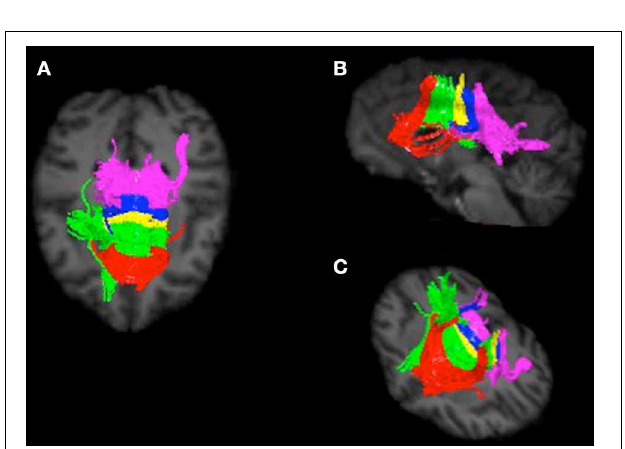
FIGURE 4 | Callosal fiber projections from a single male chimpanzee, displayed from (A) dorsal, (B) sagittal, and (C) oblique views. Color distinguishes fibers projecting into cortical regions and are as follows: prefrontal (red), premotor and supplementary motor (green), motor (yellow), sensory (blue), and parietal, temporal and occipital